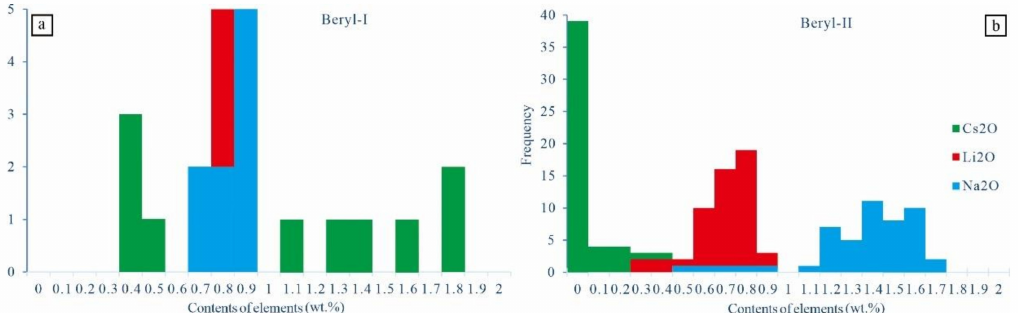
Figure 10. Frequency histogram of alkali elements of beryl from the Xianglin area. ( a ):Alkali elements of Beryl-I. ( b ): Alkali elements of Beryl-II.